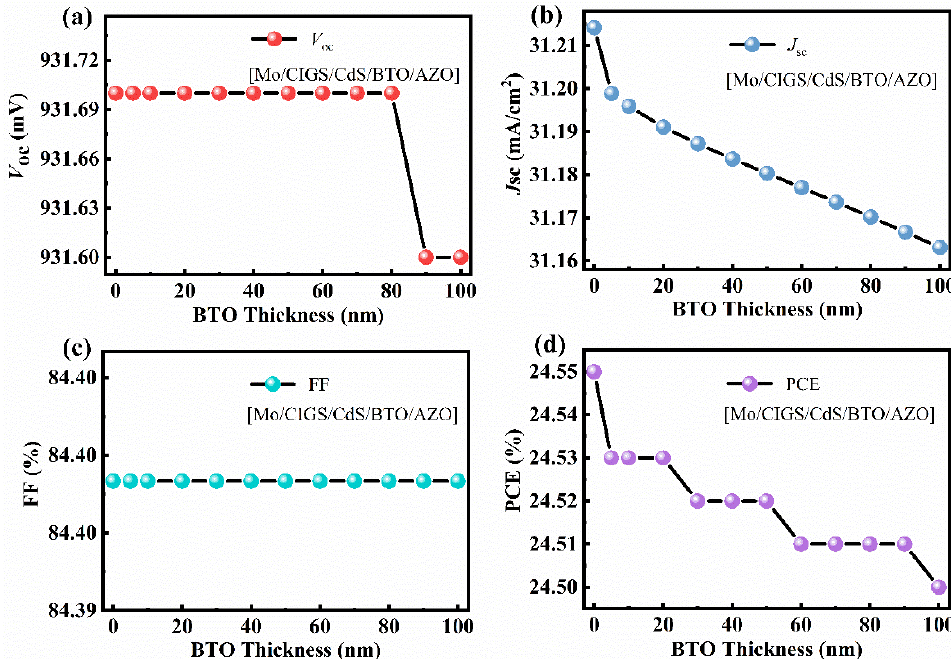
Figure 11. Effect of the BTO layer thickness on the electrical parameters of the ferroelectric-coupled CIGS solar cell with a device structure of Mo/CIGS/CdS/BTO/AZO: ( a ) V oc , ( b ) J sc , ( c ) FF, and ( d ) PCE.